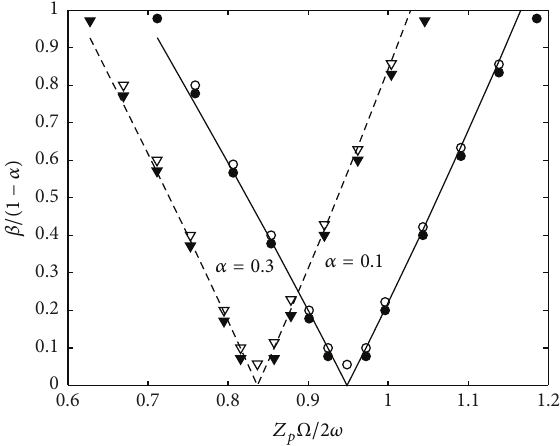
Figure 6: Dynamic instability regions with different 𝛼 . “—,” “- -,” instability region boundary with 𝛼 = 0.1, 0.3 by Floquet’s method; “ e ” “ I ,” “ 󳶃 ” “ 󳶚 ,” stable and unstable results with 𝛼 = 0.1, 0.3 by DSC